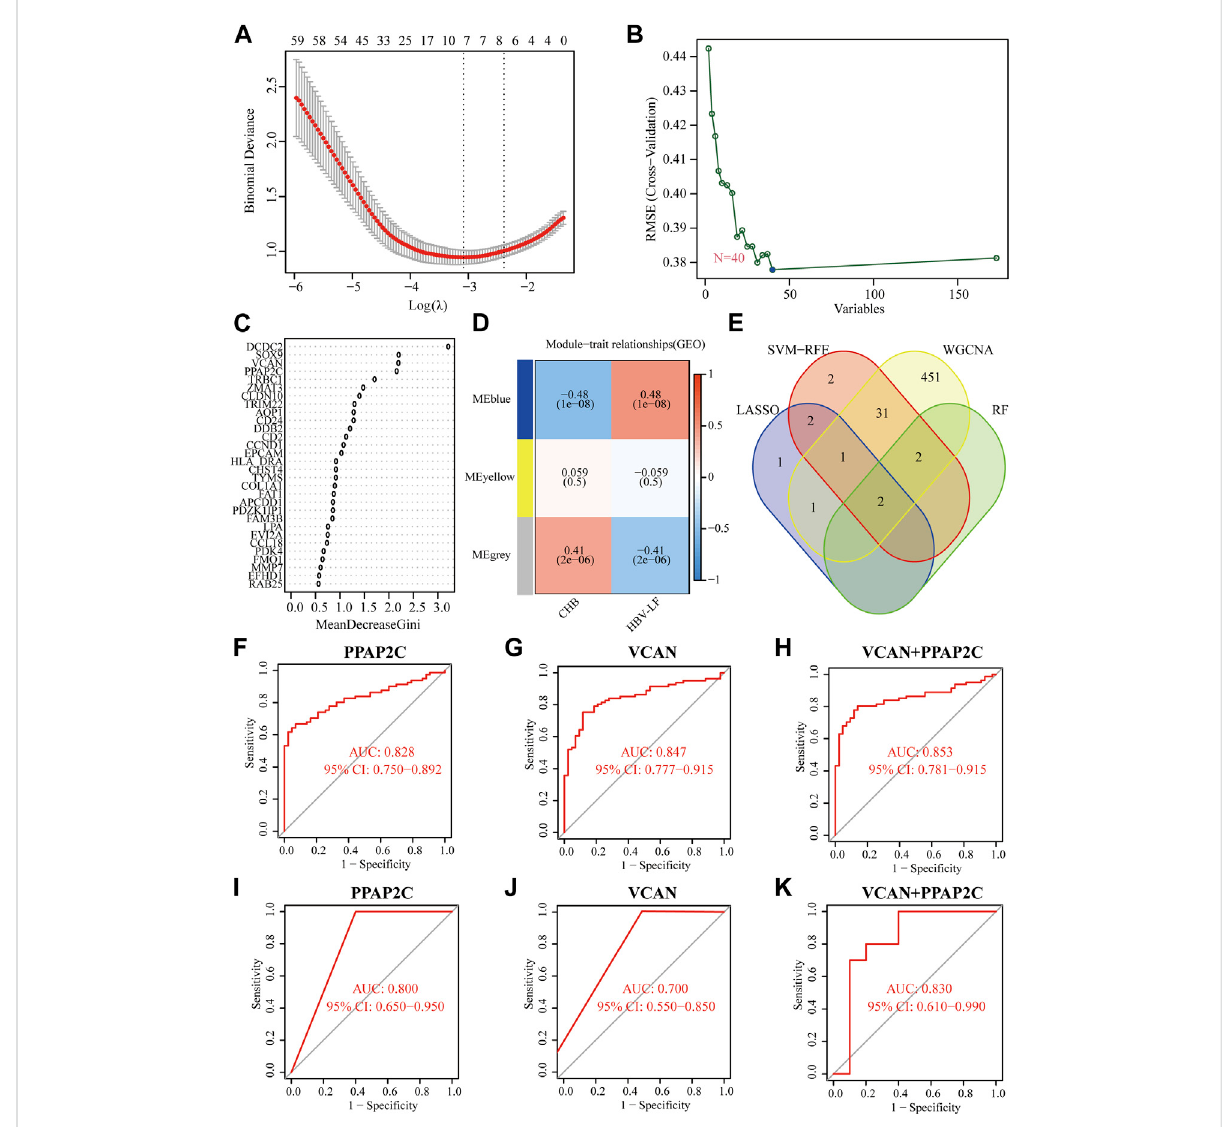
FIGURE 4 Identifying and verifying diagnostic biomarkers via the comprehensive strategy. (A) LASSO logistic regression. (B) SVM-RFE algorithm. (C) RF algorithm. (D) WGCNA analysis. (E) Venn diagram of the intersection of diagnostic biomarkers screened. (F – H) The ROC analysis of PPAP2C, VCAN, and PPAP2C + VCAN in the training set. (I – K) The ROC analysis of PPAP2C, VCAN, and PPAP2C + VCAN in the validation